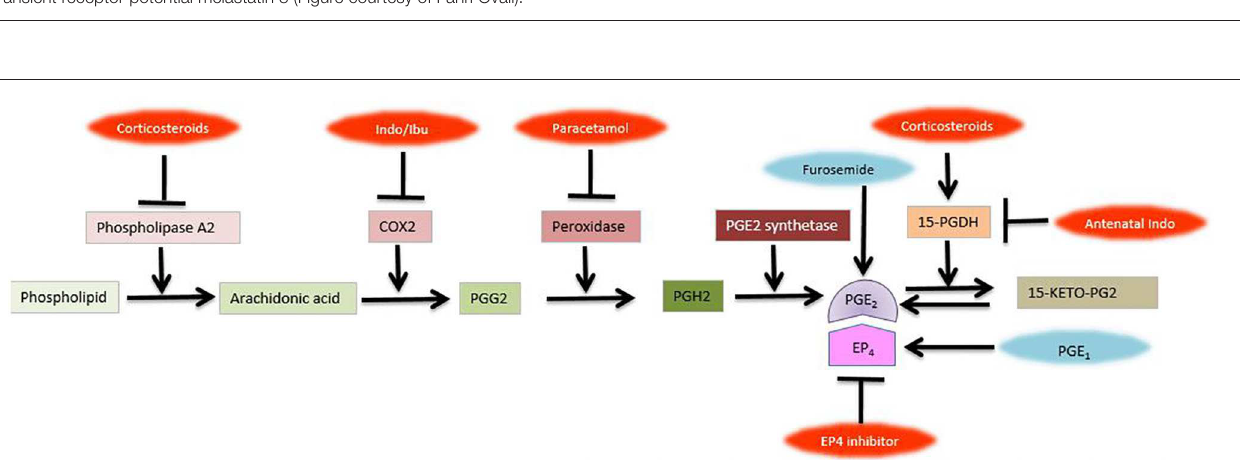
Frontiers in Pediatrics |